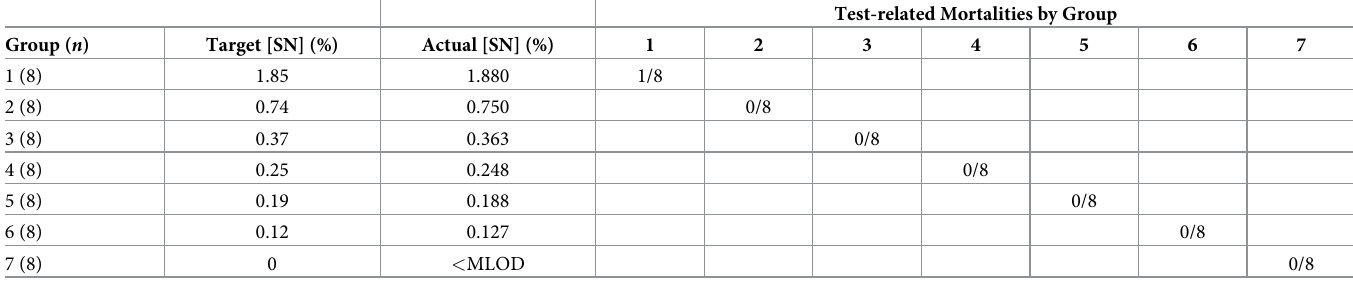
Table 3. Test-related mortalities among European starlings offered a free-choice of demineralized water treated with technical sodium nitrite (SN) and demineral- ized water in Experiment 3.